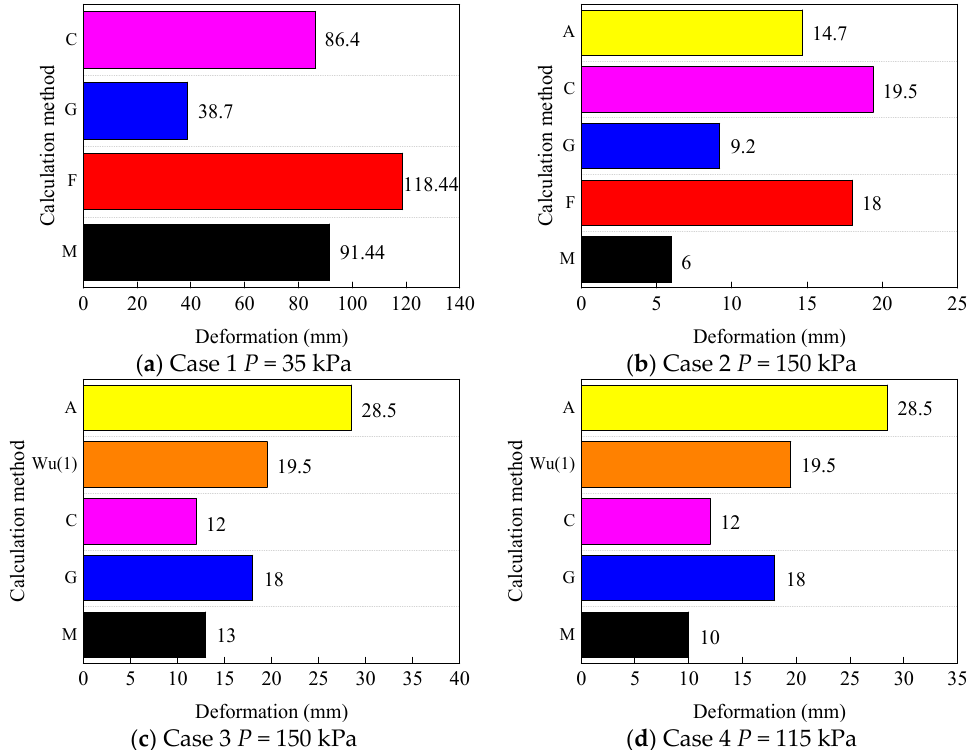
Figure 4. Comparison between measured value and calculated value in case 1–4.